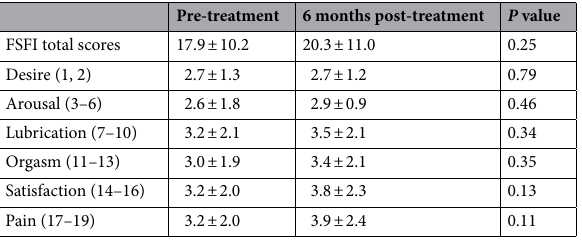
Table 5. Changes Female Sexual Function Index (FSFI) scores at baseline and 6 months post-treatment with PRP injection. Data are given as median (range) or mean ± standard deviation. Paired’s t-test.